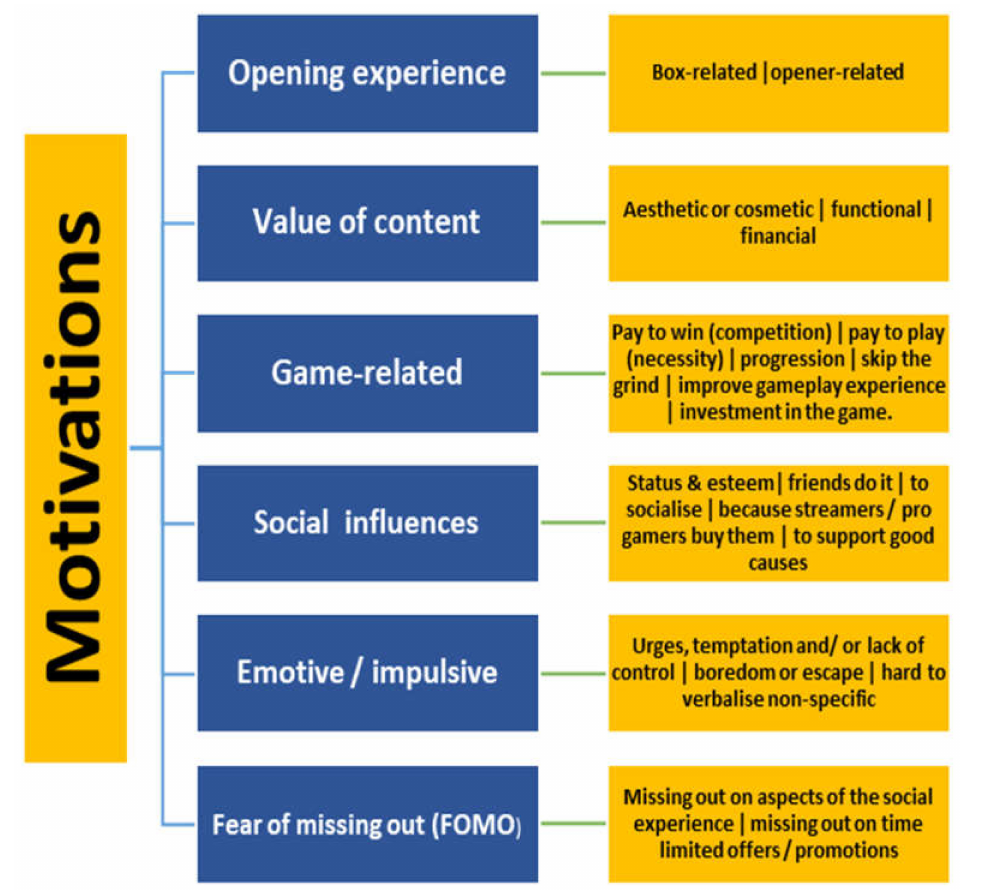
Figure 1. Motivations related to themes and subthemes identified from qualitative